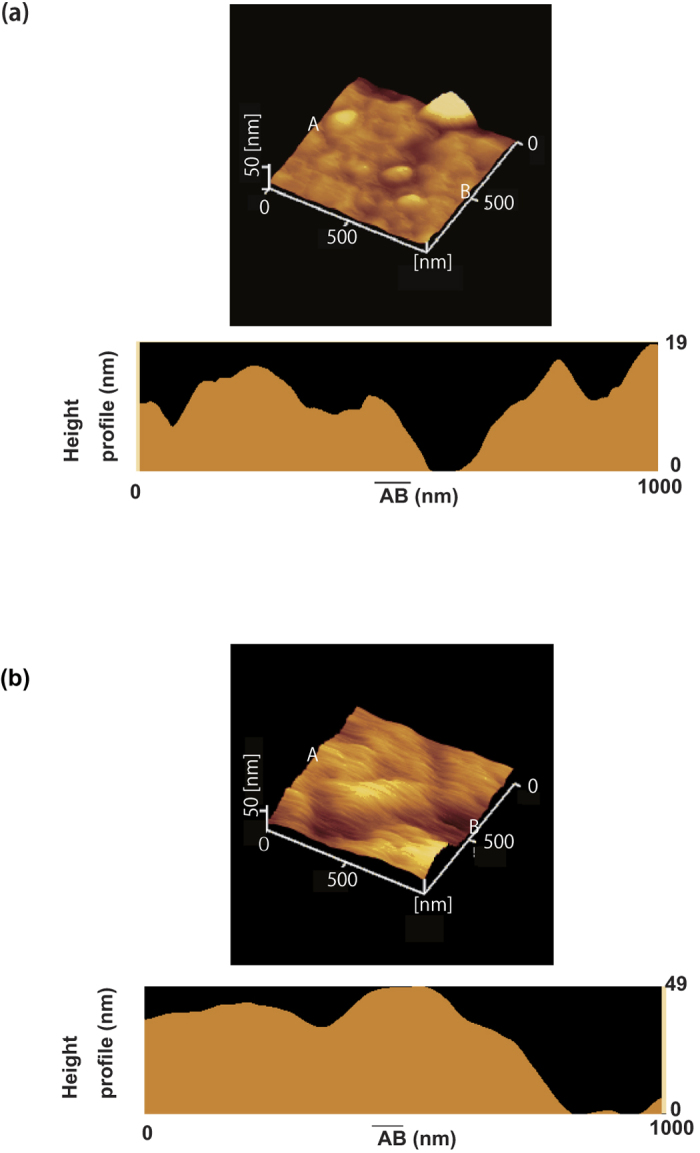
AFM images of thin films of 3 on (a) SiO2 and (b) ZrO2 gate dielectrics. Height-profile along the direction from A to B. The position of A and B are shown in the AFM images.